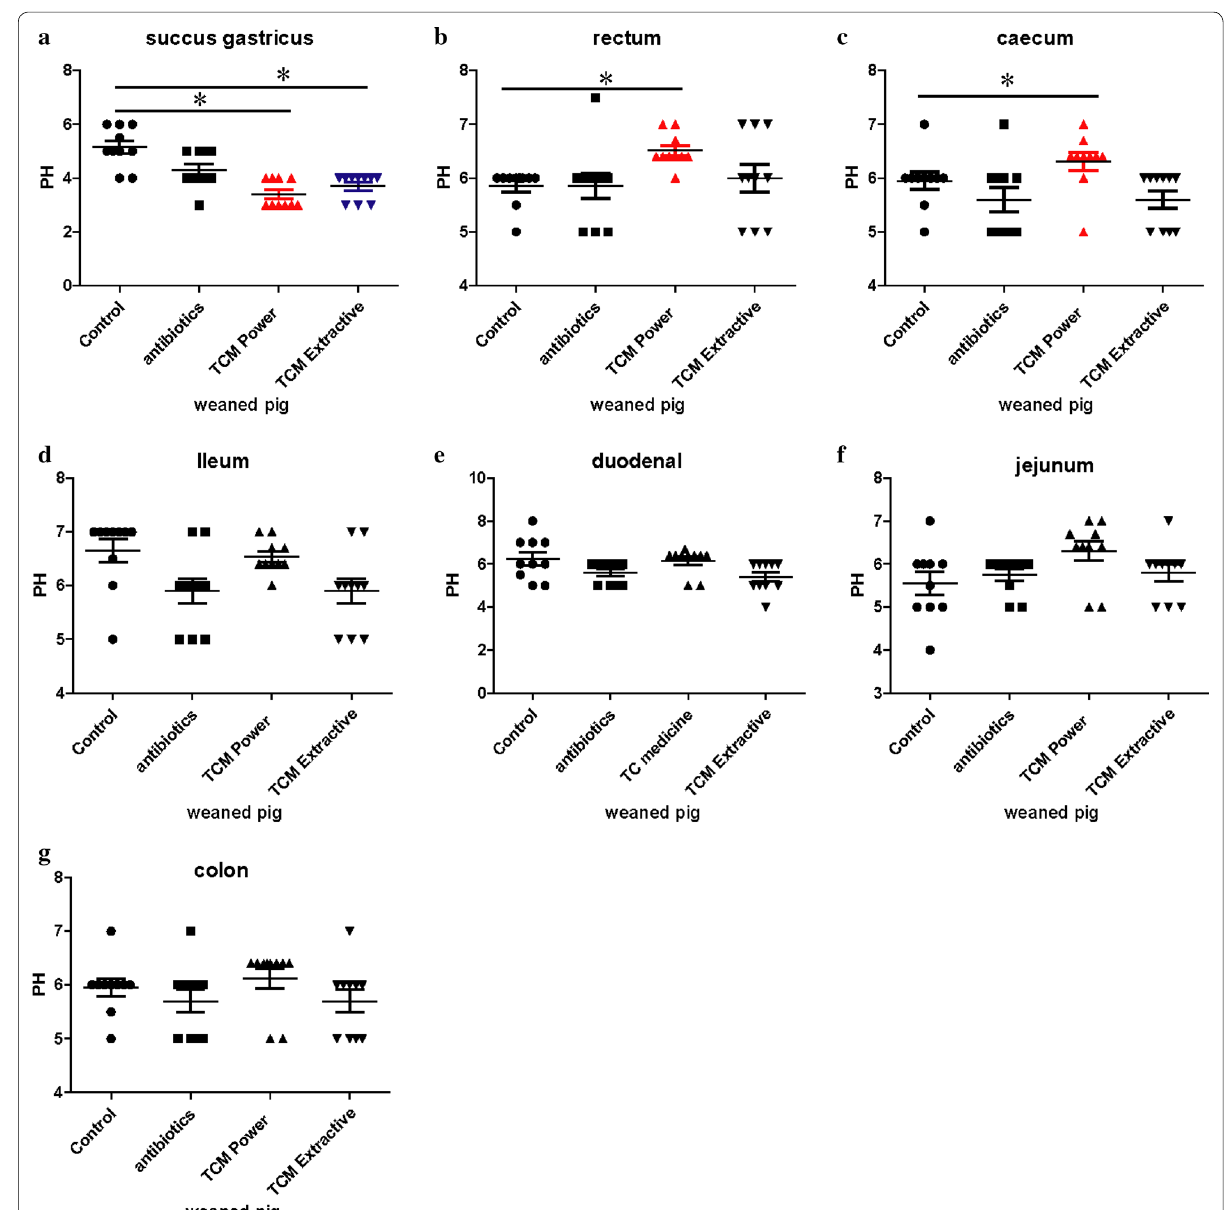
Fig. 2 Variation in pH of the gastrointestinal content of weaned piglets on day 28. a pH values of the succus gastricus. b pH values of the rectal content. c pH values of the cecal content. d pH values of the ileal content. e pH values of the duodenal content. f pH values of the jejunal content. g pH values of the colonic content. (* p <